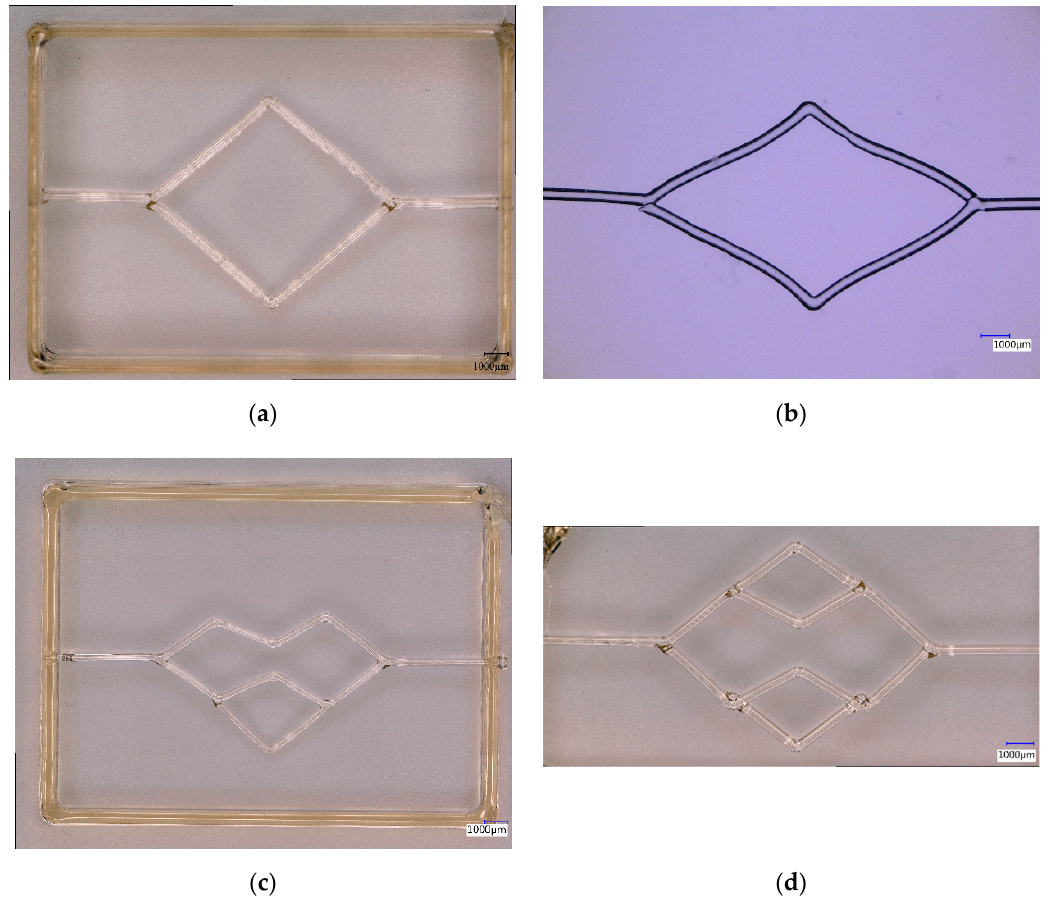
Figure A3. Sugar glass prints of various types and cast: ( a ) First order bifurcating network print; ( b ) PDMS cast of first order bifurcating network; ( c ) Partial second order bifurcating network only showing second bifurcation in lower network part; ( d ) Second order bifurcating network similar to Figure 4c.